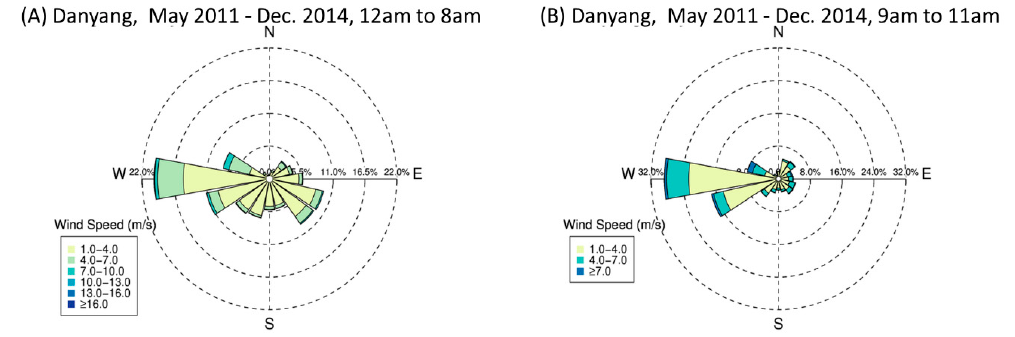
Figure 4. ( A ) Diurnal variation in NO 2 concentrations from surface monitors over the Jecheon (blue), Danyang (red), and the SMA (whisker boxes) regions, and ( B ) normalized diurnal variations from the Danyang site for NO 2 , PM 10 , SO 2 , and CO concentrations.